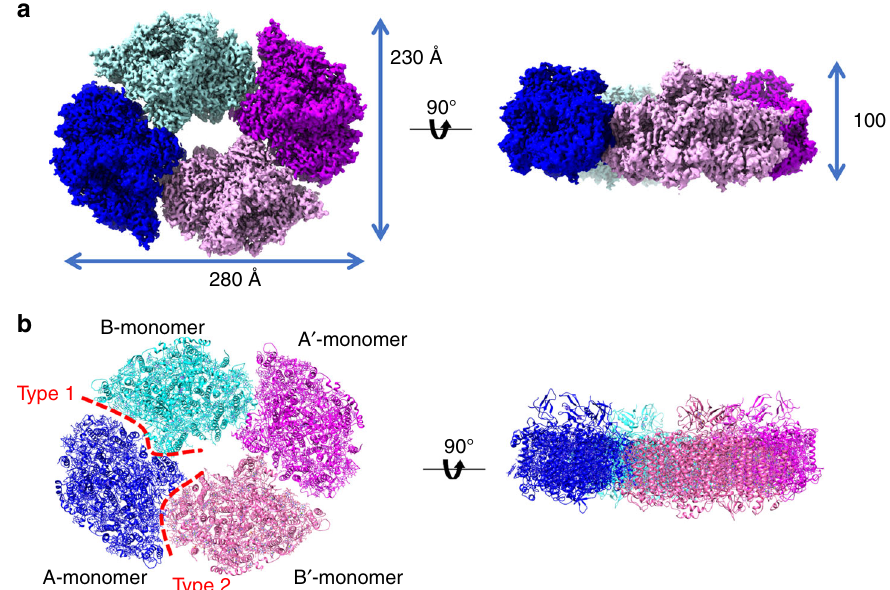
Fig. 1 Overall structure of the PSI tetramer. a The 3D cryo-EM density map of the PSI tetramer viewed along the membrane normal from the stromal side (Left) and its side view (Right). b The structure of the PSI tetramer viewed along the membrane normal from the stromal side (Left) and its side view